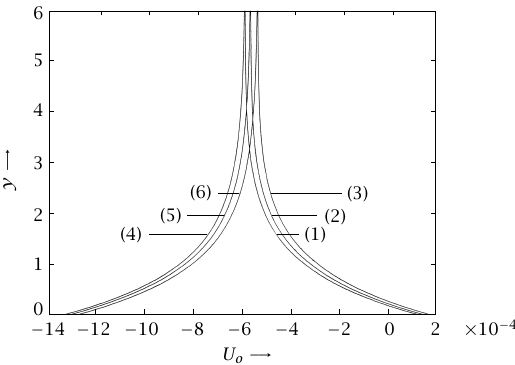
Figure 4.3 . Outer flow axial velocity component of fluid U o for R = 500, 4 = 0 . 05, t = 2. (1) X = − 1, λ = 0 . 01, (2) X = − 1, λ = 0 . 16, (3) X = − 1, λ = 0 . 31, (4) X = 1, λ = 0 . 01, (5) X = 1, λ = 0 . 16, (6) X = 1, λ = 0 . 31.